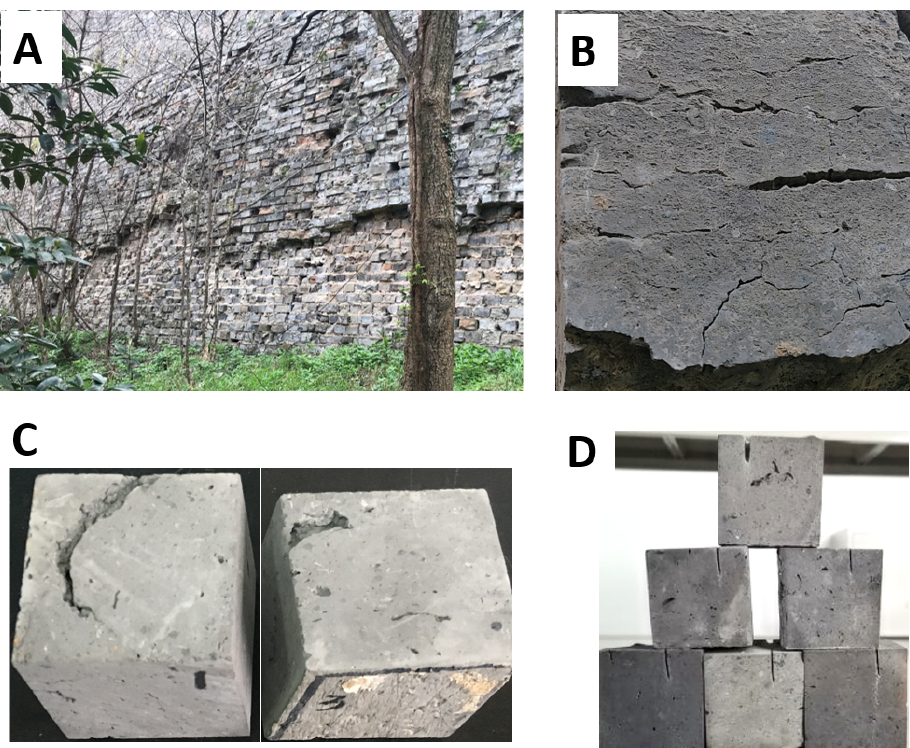
Figure 1. View of the city wall brick samples; ( A ) ancient Nanjing City Wall; ( B ) feature photo of wall brick; ( C ) brick cubes with natural cracks; ( D ) brick cubes with simulated cracks.